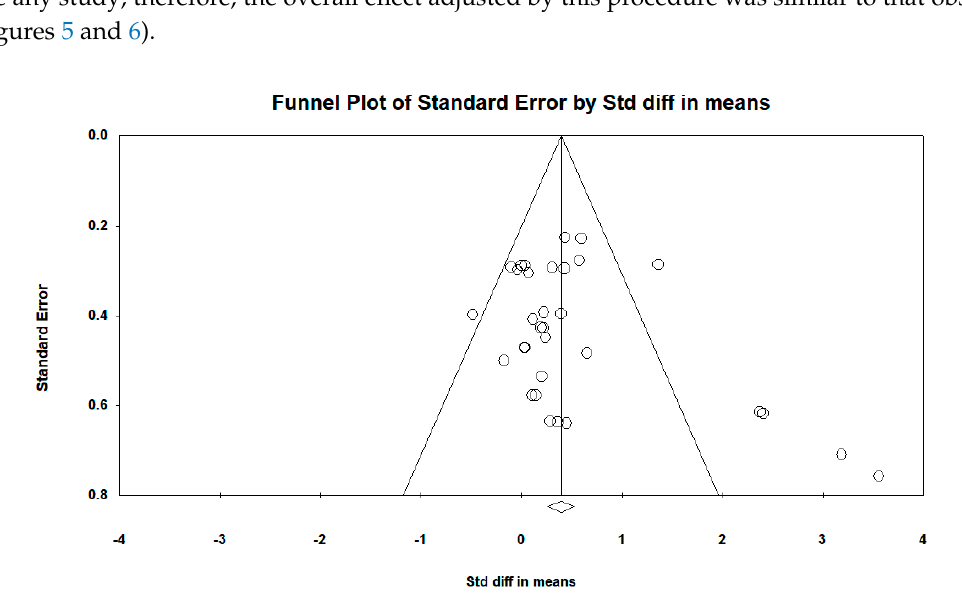
Figure 6. Funnel plot diagram of the standard error ( y -axis) and the SMD ( x -axis), after incorporating the Duval and Tweedie “trim and fill” procedure: pre–post intra-group difference in the intervention group with resistance therapy in all follow-ups. Regarding the difference in GMFM scale between groups, the funnel plot visually presented an asymmetry with a larger number of studies to the right (in favor of resistance therapy). When incorporating the Duval and Tweedie “trim and fill” procedure, the model included six studies from the left (represented as black circles). The best adjusted (unbiased) estimate using this procedure was, therefore, against intervention with an adjusted overall MD of − 0.21 and − 0.13 using the fixed-effects and random-effects models, respectively (see Figures 7 and 8).